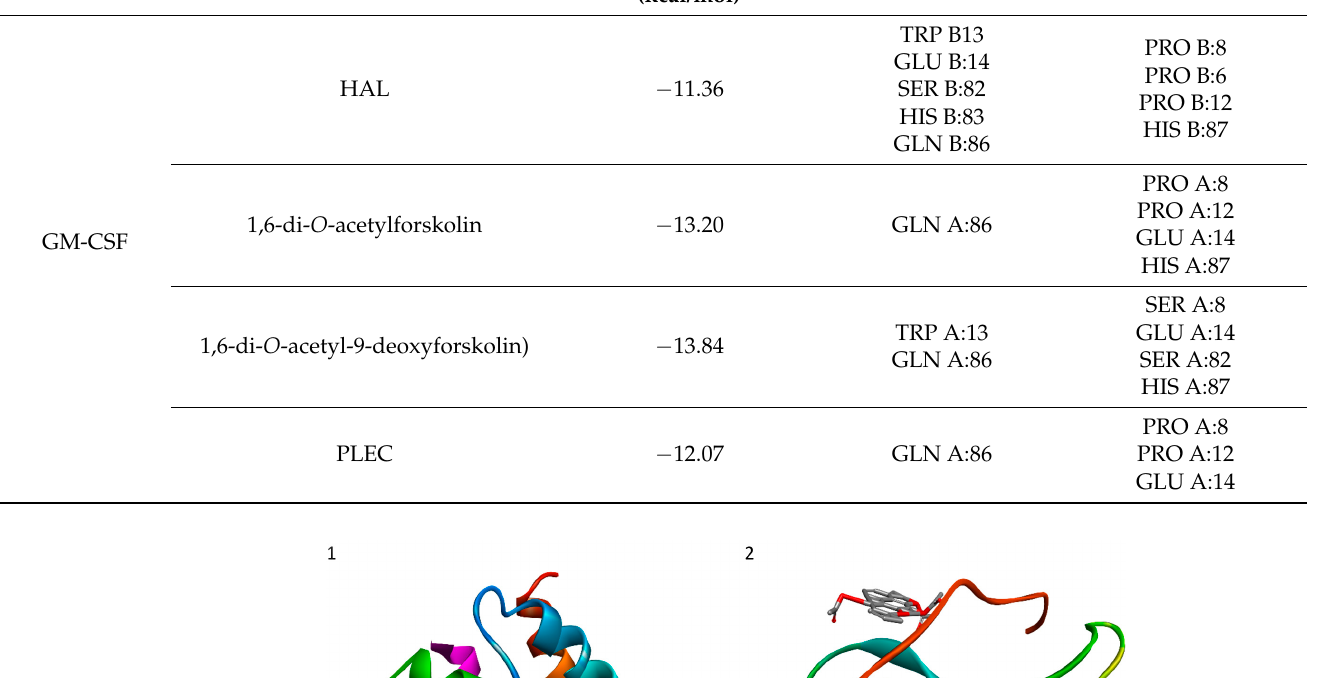
Binding Free Energy Hydrogen Bonding Other Interactions (kcal/mol)